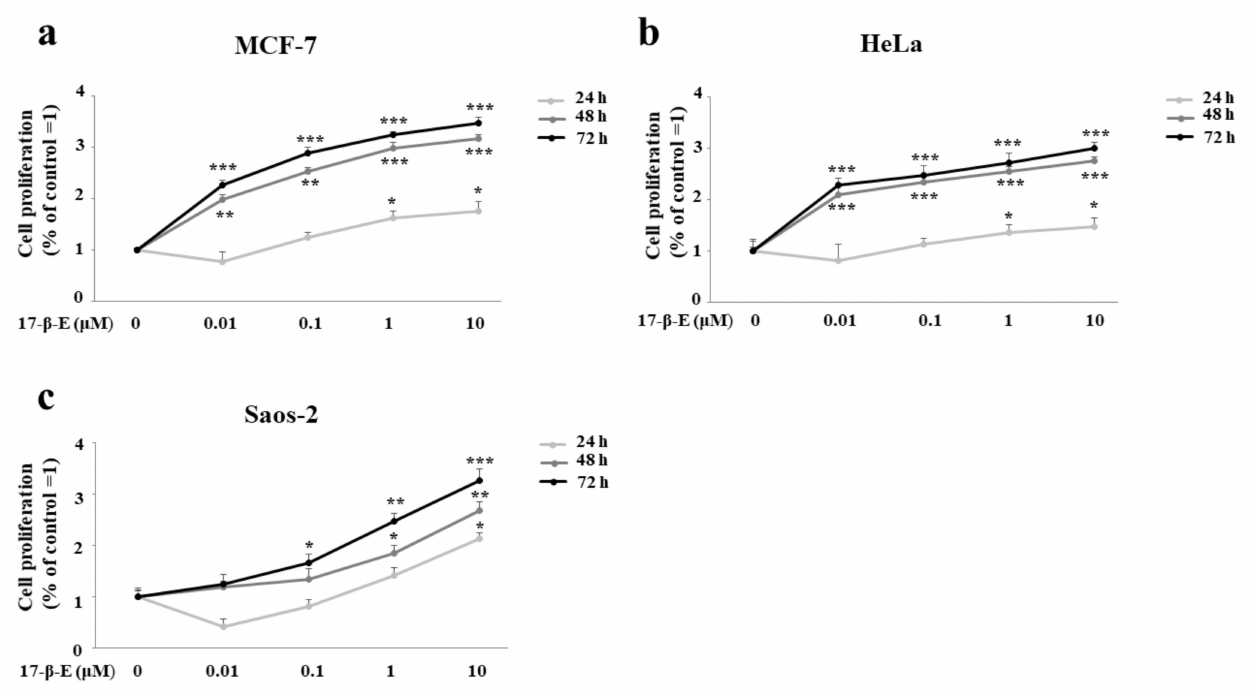
Figure 3. Hyperproliferation induced by treatment with 17- β -E2 in MCF-7, HeLa and Saos-2 cell lines. Cell lines were treated with increasing concentrations of 17- β -E2 (0.01–10 µ M) and the proliferation rate was measured through the MTT test. Each panel is composed of three curves obtained from the data measured at 24, 48 and 72 h of treatment. In particular, panel ( a ) shows the results related to the cell line MCF-7; panel ( b ) refers to HeLa cells; and finally, panel ( c ) highlights the data related to Saos-2 cells. Three independent experiments were carried out, and the values are expressed as the mean ± standard deviation (sd). * denotes p < 0.05 versus the control; ** denotes p < 0.01 versus the control; *** denotes p < 0.001 versus the control. Analysis of Variance (ANOVA) was followed by a Tukey–Kramer comparison test. Each treatment was carried out in